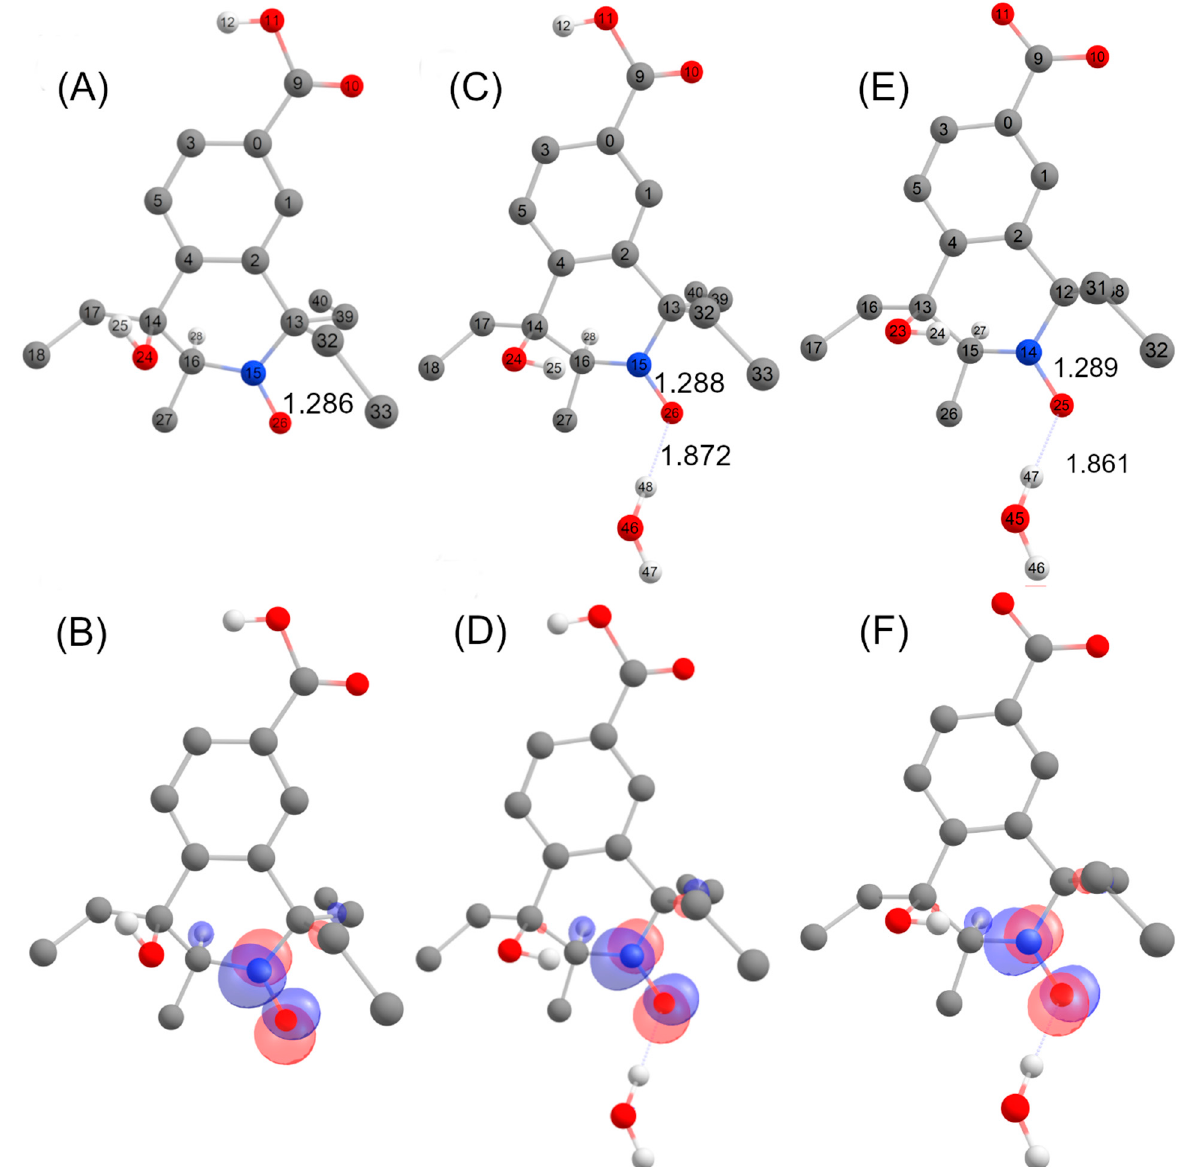
Figure 11. DFT- optimized structures with atom labelling together with selected metrical parameters (N-O and O-H bond distances, Å) for structures C (carboxylic acid form) ( A ), C (carboxylic acid form) + H 2 O ( C ), C (carboxylate form) + H 2 O ( E ) and localized SOMOs of structures C (carboxylic acid form) ( B ), C (carboxylic acid form) + H 2 O ( D ) and C (carboxylate form) + H 2 O ( F ).